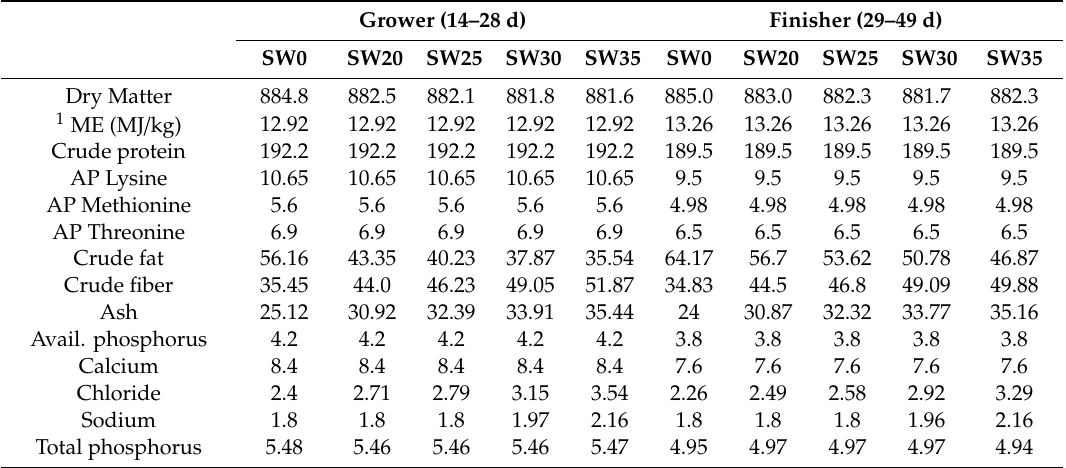
Table 2. Chemical composition (g / kg, unless stated otherwise) of experimental diets in grower and finisher